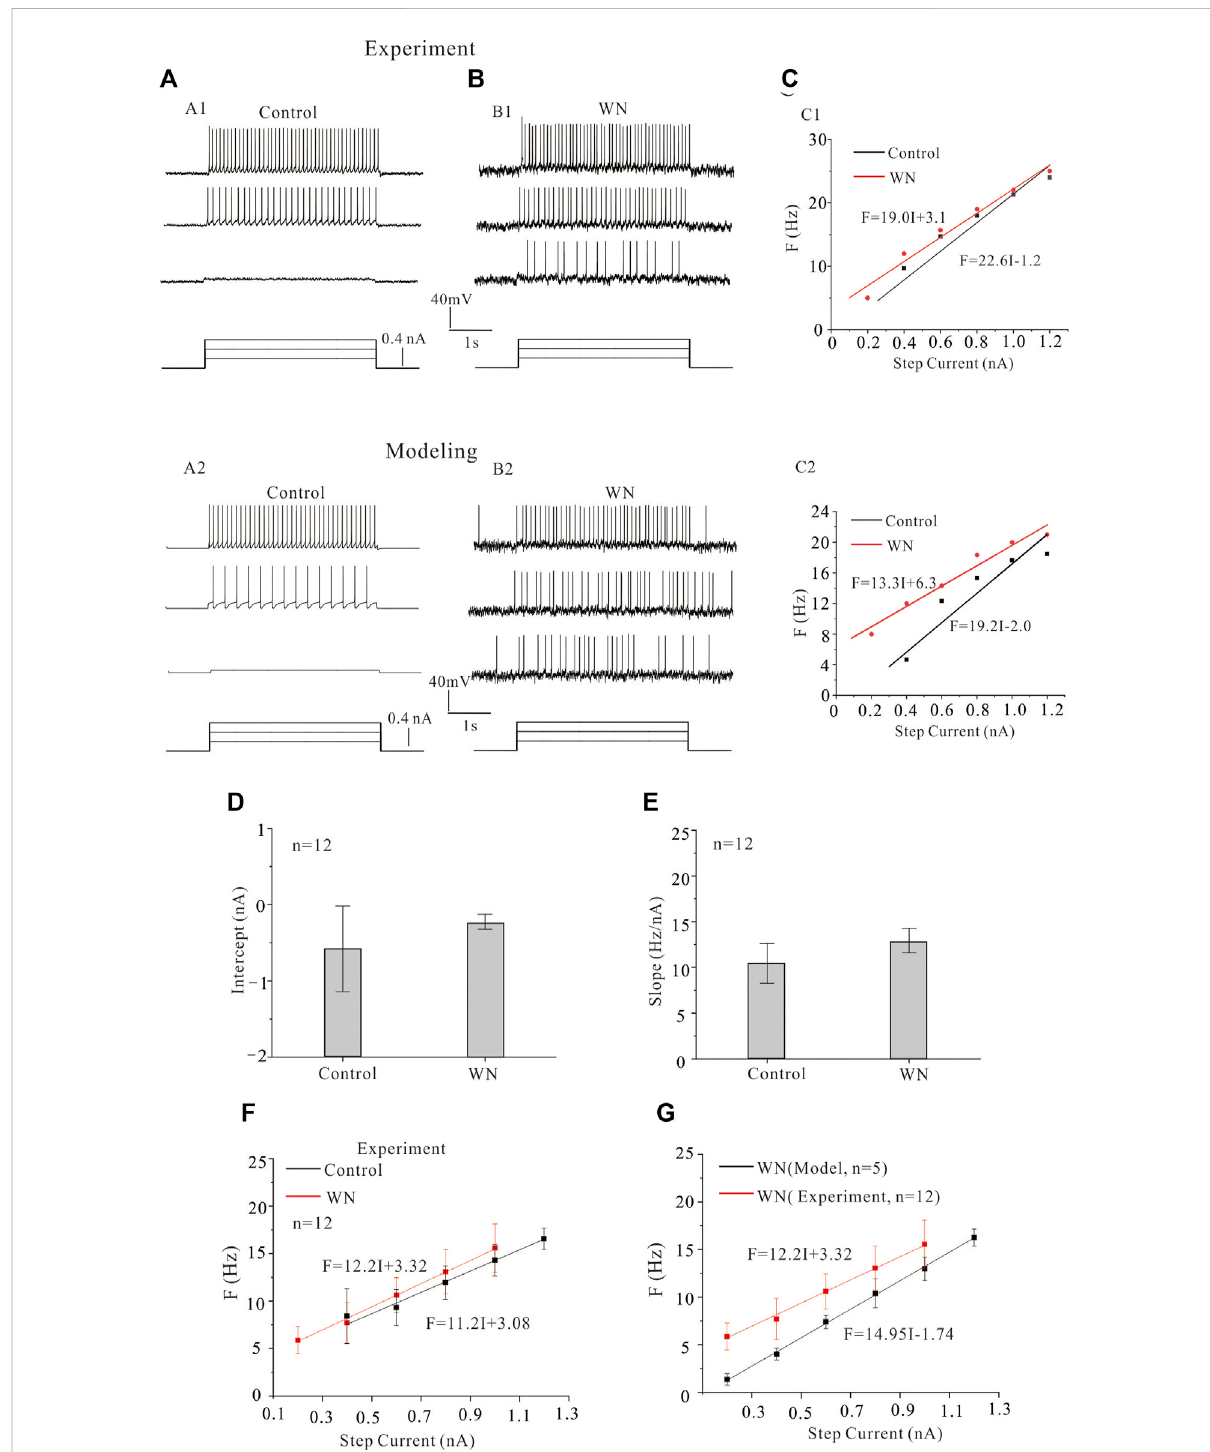
FIGURE 4 Effect of white noise on frequency-current (F-I)relationships. (A,B) Repetitive fi ring in HG motoneurons was induced by injecting step currents of 3 s duration and 0.2 nA step in both experiments (A1,B1) and models (A2,B2) recordings without (control) and with white noise, respectively. (C) TheF-Irelationshipsweremeasuredfortheexperimentdata (C1) andmodelingresults (C2) .WhitenoiseincreaseddischargeratesandshiftedtheF-I curve to the left. (D,E) Statistical results from 12 motoneurons showed that white noise slightly increased the intercept and slope of the F-I relationship. (F) The F-I relationships for control (black line) and white noise (red line) were established from the statistical results (D,E) . (G) The F-I relationship with WN was established from simulation data of 5 HG motoneuron models (black line), and the F-I curve from the experimental data with WN was plotted in the same diagram to show the difference between the experimental and modeling data recorded with white